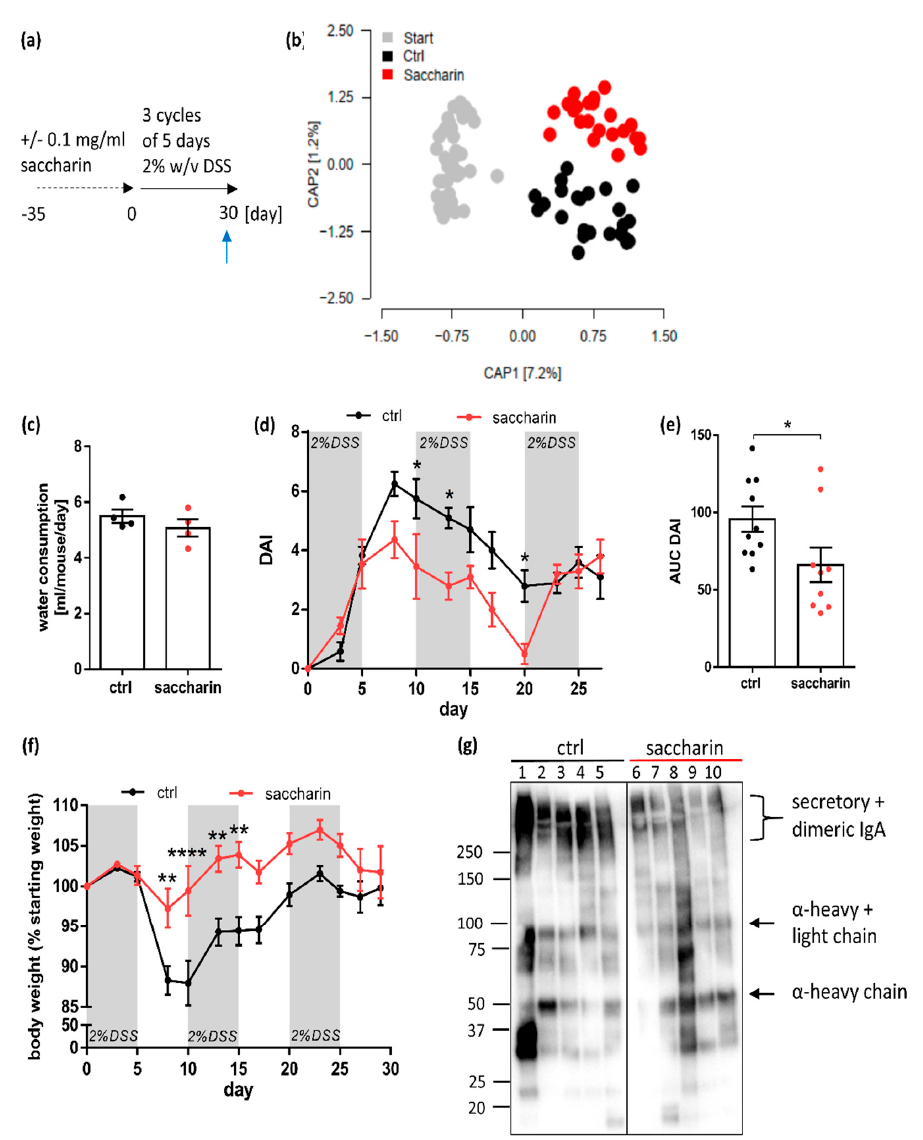
Figure 4. Five weeks of saccharin pre-feeding has a protective influence on chronic DSS-colitis in mice. ( a ) Drinking water of mice was supplemented with 0.1 mg / mL saccharin or left untreated for a period of five weeks, after which saccharin treatment was stopped and chronic colitis was induced in 3 cycles of 2% DSS-treatment via the drinking water. The blue arrow indicates the day of organ sampling. ( b ) Beta-diversity of fecal microbiome after five weeks of supplementation shown as unifrac-distance. Start: n = 48, ctrl and saccharin n = 24. ( c ) Water consumption during the first DSS-cycle of chronic colitis treatment of previously saccharin or untreated mice; n = 4 of two di ff erent experiments. Degree of intestinal inflammation is shown in ( d ) as DAI over time, in ( e ) as AUC of the DAI and in ( f ) as body weight loss over time. ( d ) and ( f ) n = 11–12 and ( e ) n = 9–10 from two independent experiments. ( g ) Denaturing, non-reducing WB of fecal proteins against IgA α -chain from DSS-ctrl or DSS-saccharin mice. Representative WB from two di ff erent experimental rounds. In ( d ) and ( f ) all mice were included until time of death while for ( e ) and ( g ) mice which were taken out at earlier time points due to abrogation criteria were excluded. Values are shown as mean ± SEM. * p ≤ 0.05; ** p ≤ 0.01; **** p ≤